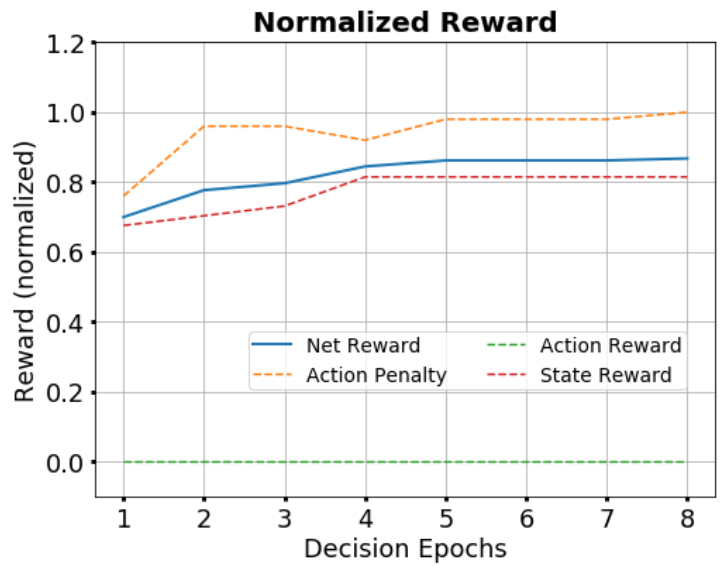
( b ) Figure 21. ( a ) Progression of the cuttings bed ( b ) Progression of the normalized Euclidean distance (blue line) of the system states for 𝑎 𝑠𝑒𝑞1 to an acceptable goal state (shown by the green dotted line, here taken to be a state at a normalized Euclidean distance of 0.2). By the fourth action, the system has already moved close to the 0.2 line (by cuttings bed being reduced to the goal state), where it stays until the end. Figure 22 shows the progression